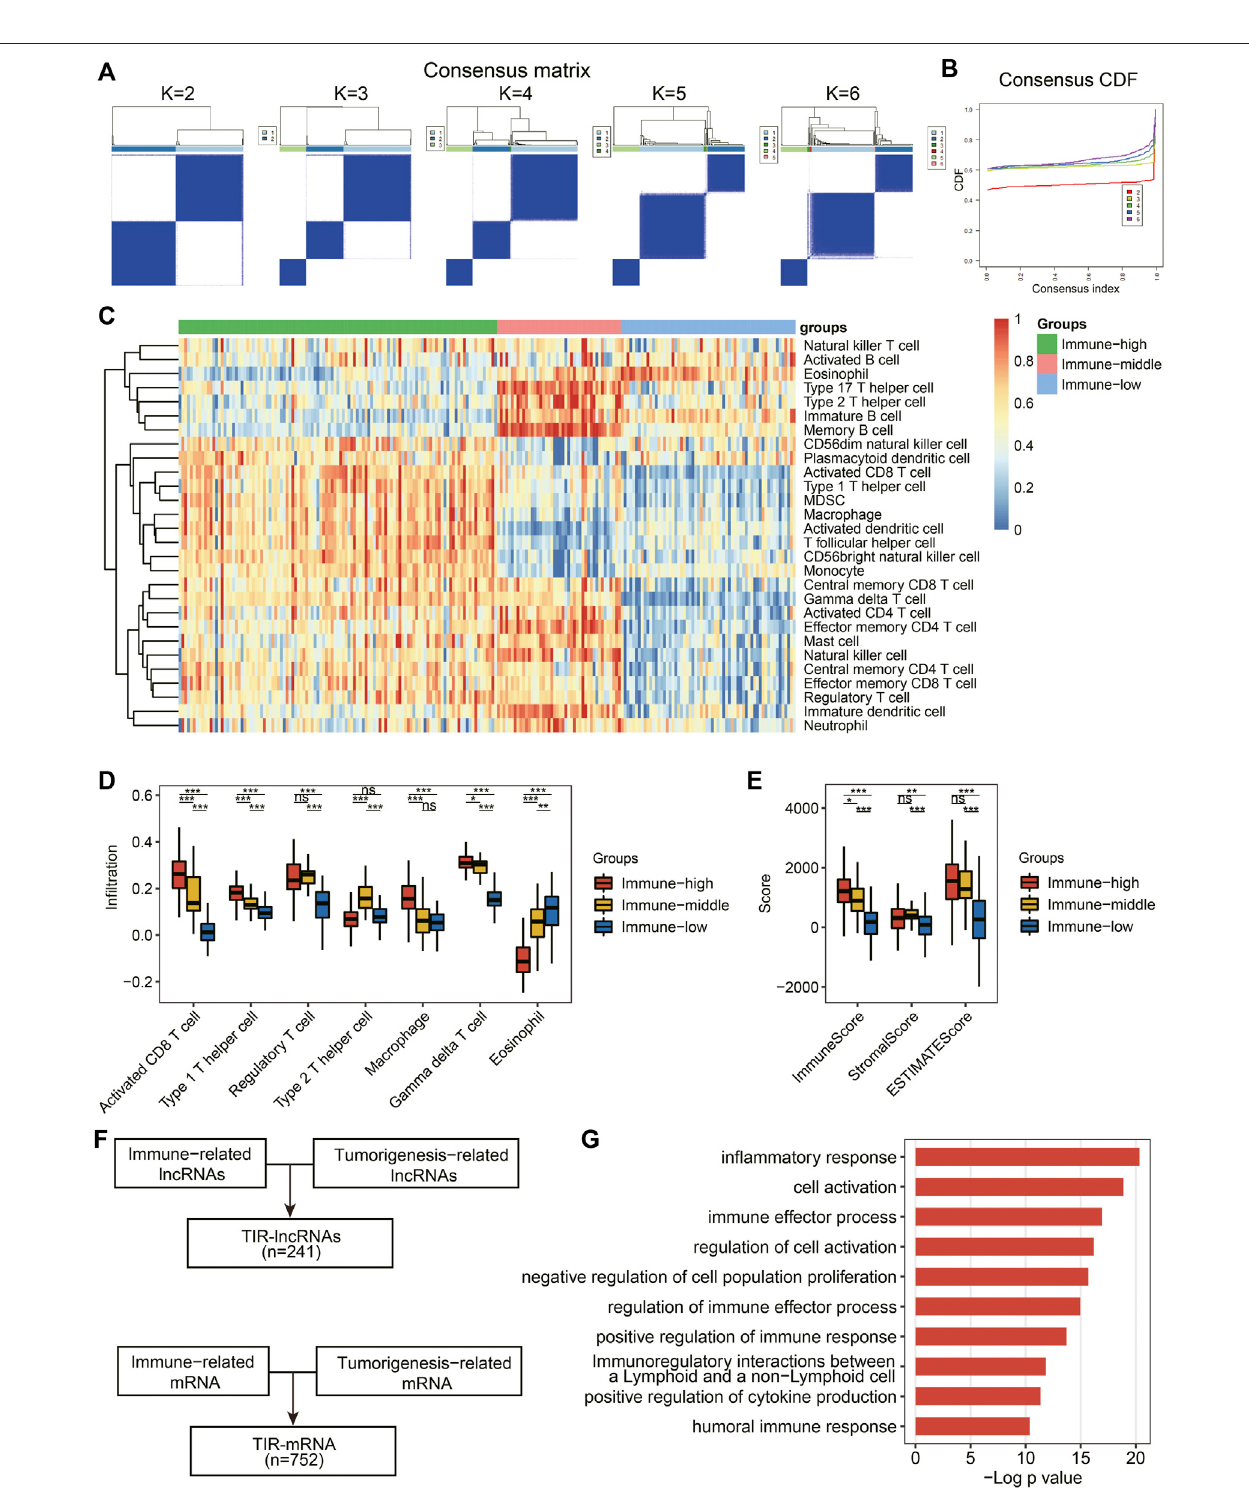
FIGURE 4 | Identi fi cation of TIR-lncRNAs and functional enrichment. (A) Sample clustering heatmap for k = 2 to 6, respectively. (B) The cumulative distribution function(CDF)plotsfork=2to6. (C) Heatmapofnormalizedenrichmentscoresforin fi ltrationof28immune-celltypes. (D) Comparisonsamongtheimmune-highgroup, the immune-middle group, and the immune-low group for seven immune-cell types. (E) Comparisons among the immune-high group, the immune-middle group, and theimmune-lowgroupforimmunescore,stromalscore,andestimatescore. (F) Identi fi cationofTIR-lncRNAsandTIR-mRNAs. (G) BarplotsshowedthemainGO enrichment pathways of